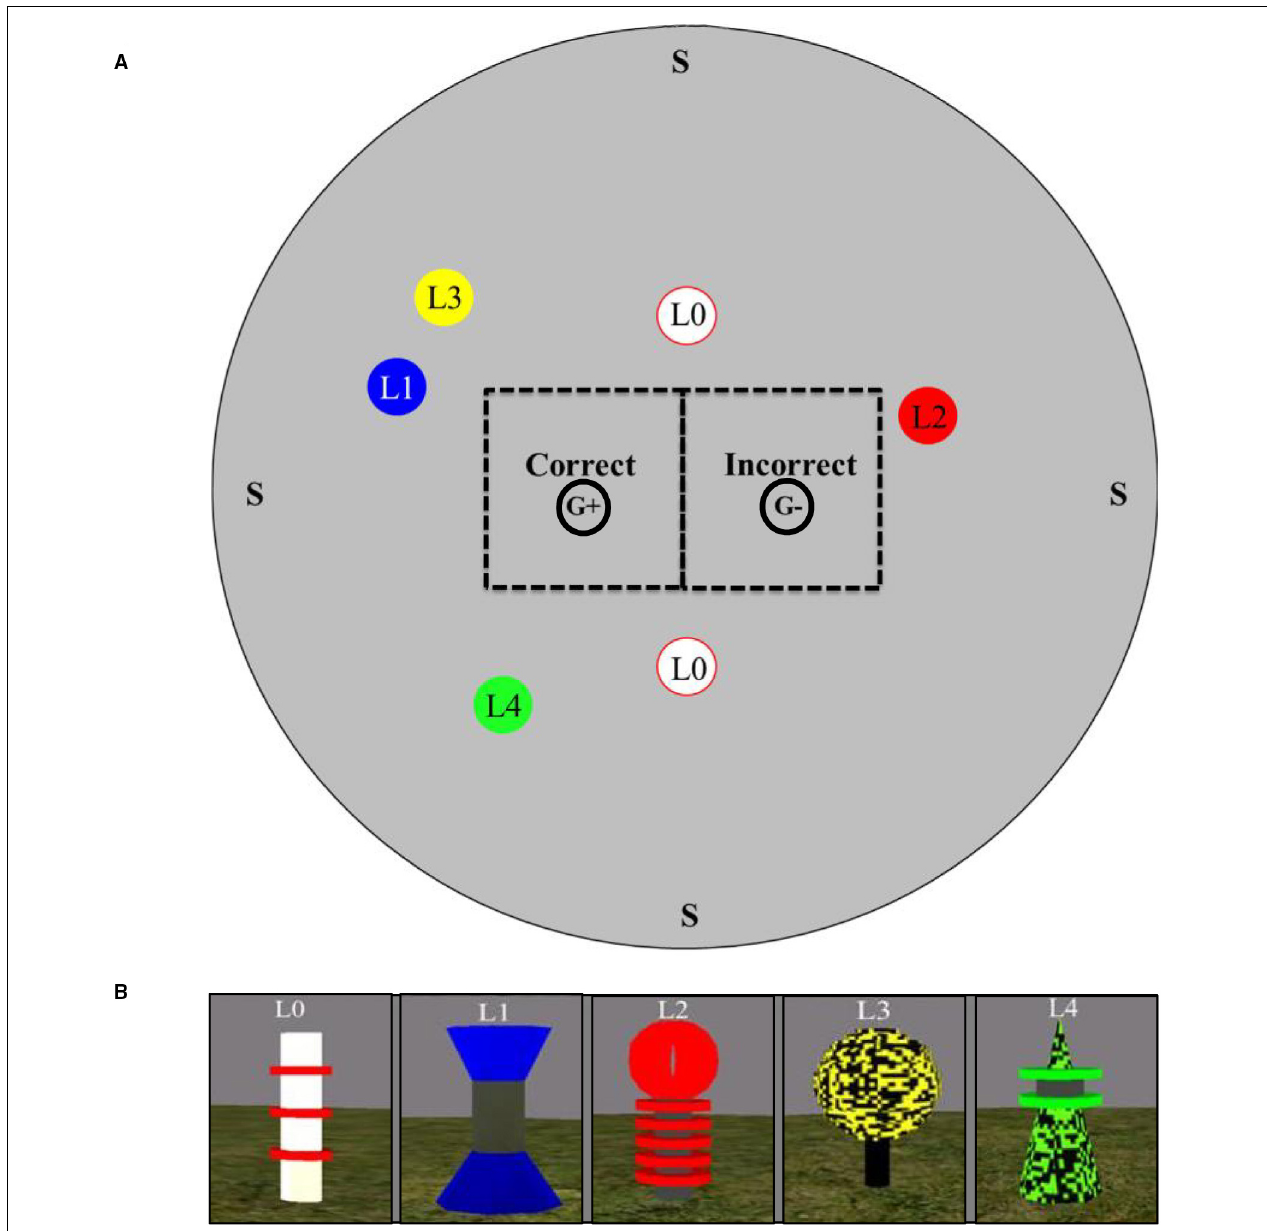
FIGURE 1 | (A) Overhead view of the virtual environment search space illustrating the location of all landmarks. Please note that the presence of all landmarks is for illustrative purposes only—landmarks were never presented simultaneously to participants (see text for details). Please also note that the location of Landmark 3 (L3) and Landmark 4 (L4) illustrate only one potential location depending on group (see text for details). For illustrative purposes, potential start locations are indicated with an “S”. Also for illustrative purposes,